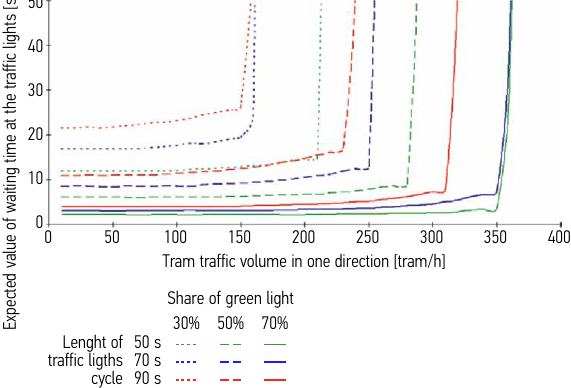
Fig. 10. Expected value of waiting time at the traffic